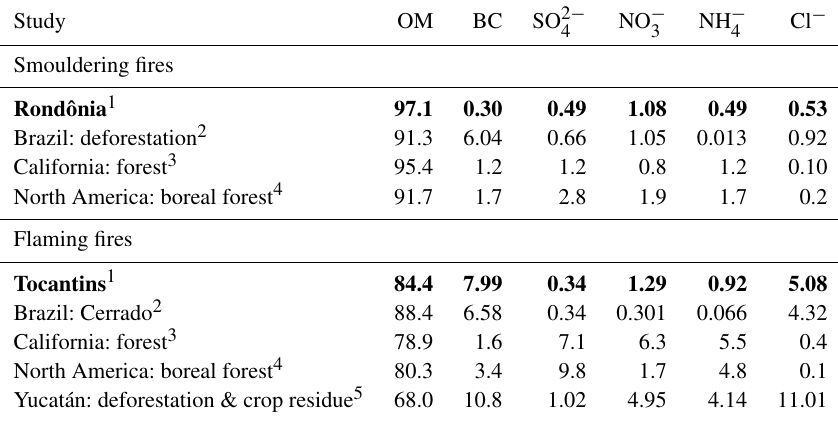
Figure 3. Mass fraction of aerosol components as a percentage of total aerosol mass including black carbon, organic aerosol, chloride, ammonium, sulfate and nitrate for the Rondônia fire and Tocantins fires, as well as values for previous studies from the Yucatán (Yokelson et al., 2003), Brazil (Ferek et al., 1998), California (Sahu et al., 2012) and North America (Kondo et al., 2011). Table 4. Mass fraction of aerosol components as a percentage of total aerosol mass including black carbon, organic aerosol, chloride, ammonium, sulfate and nitrate for the Rondônia fire and Tocantins fires, as well as values from previous studies. Ferek et al. (1998) and Yokelson et al. (2009) reported a percentage total including other particulate matter that we did not measure in our study; therefore we recalculated the values presented just including BC, organics and inorganics in order to compare values. OA for the two Brazilian values estimated assuming OM / OC is 1.6 in fresh smoke (Yokelson et al., 2009; Akagi et al., 2012). Values in bold are from this